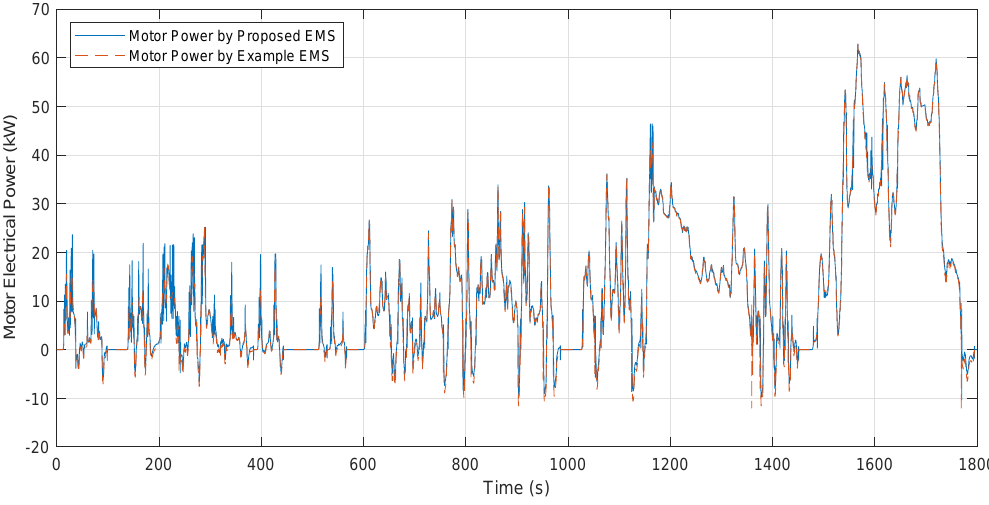
Figure 14. Comparison of electrical power of traction motor.